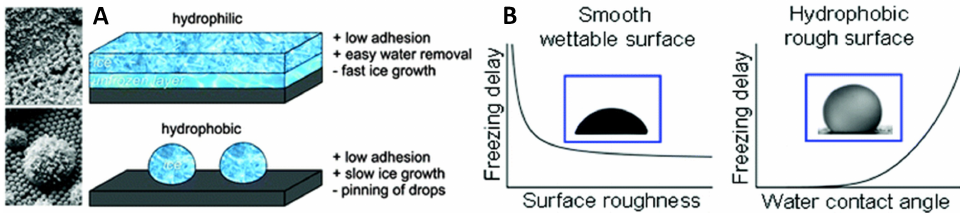
Figure 10. ( A ) Advantages and disadvantages of hydrophobic and hydrophilic surfaces in anti-icing design; ( B ) Competing effects of wettability and surface roughness in heterogeneous nucleation at hydrophobic surfaces. Reprinted with permission from Refs. [50,110], respectively. c (cid:13) 2015 Royal Society of Chemistry; c (cid:13) 2011 American Chemical Society.